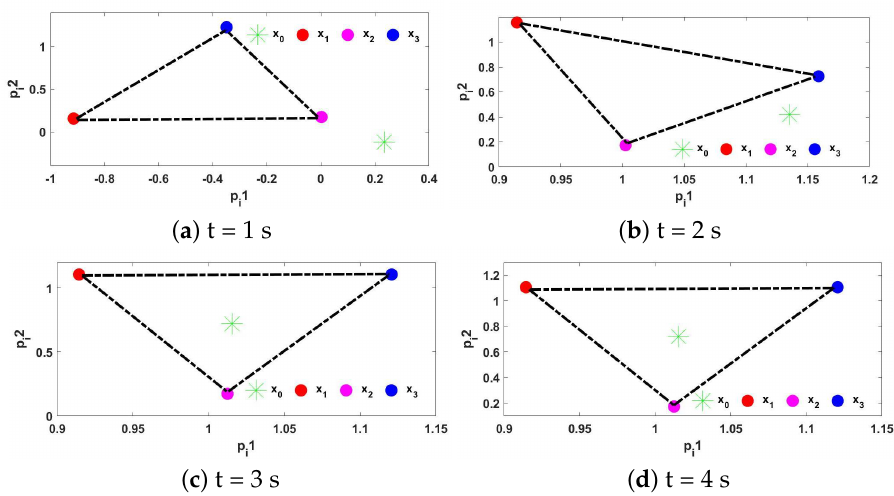
Figure 6. States trajectory snapshots of agents at different times.